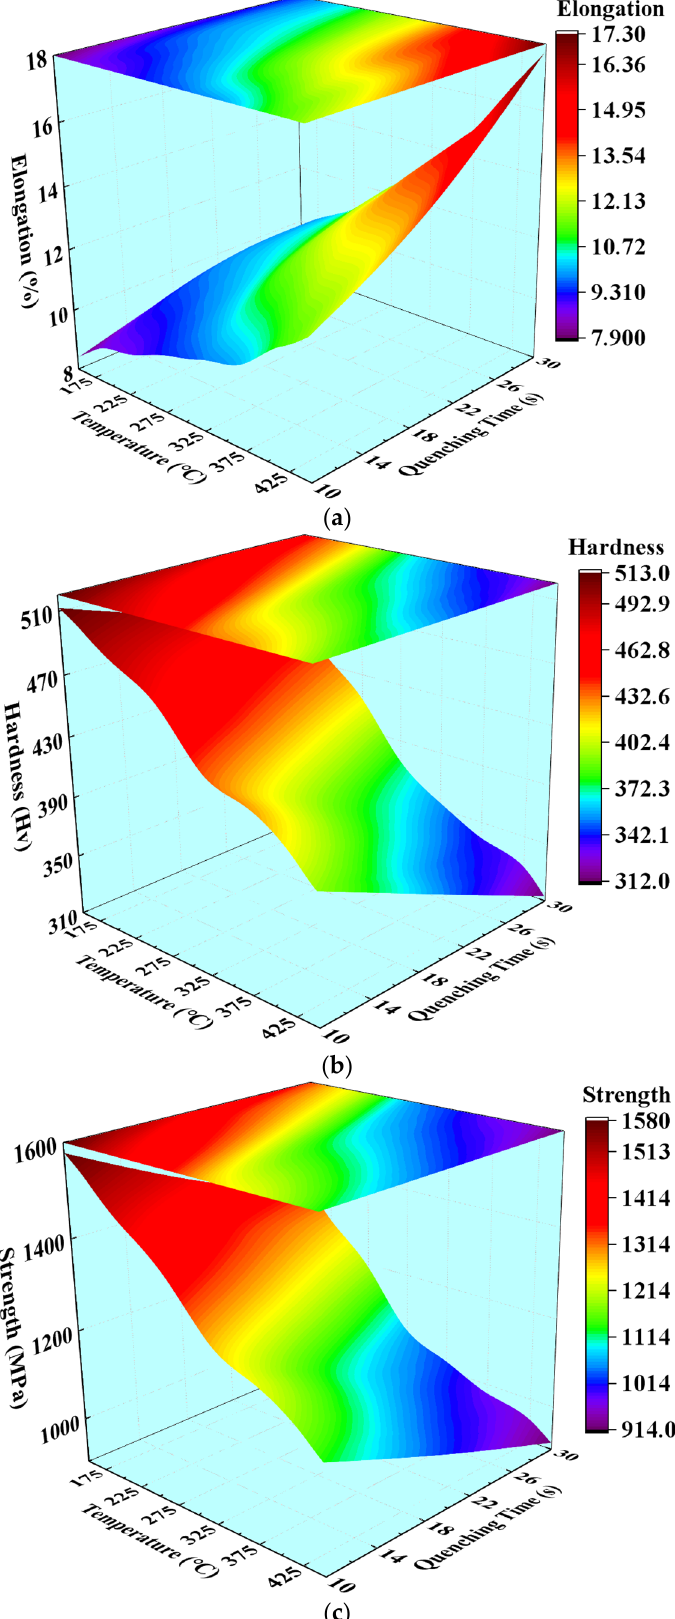
Figure 16. Mapping surfaces of ( a ) elongation at break, ( b ) hardness, and ( c ) tensile strength, which varied with the quenching time and the temperature of the die.